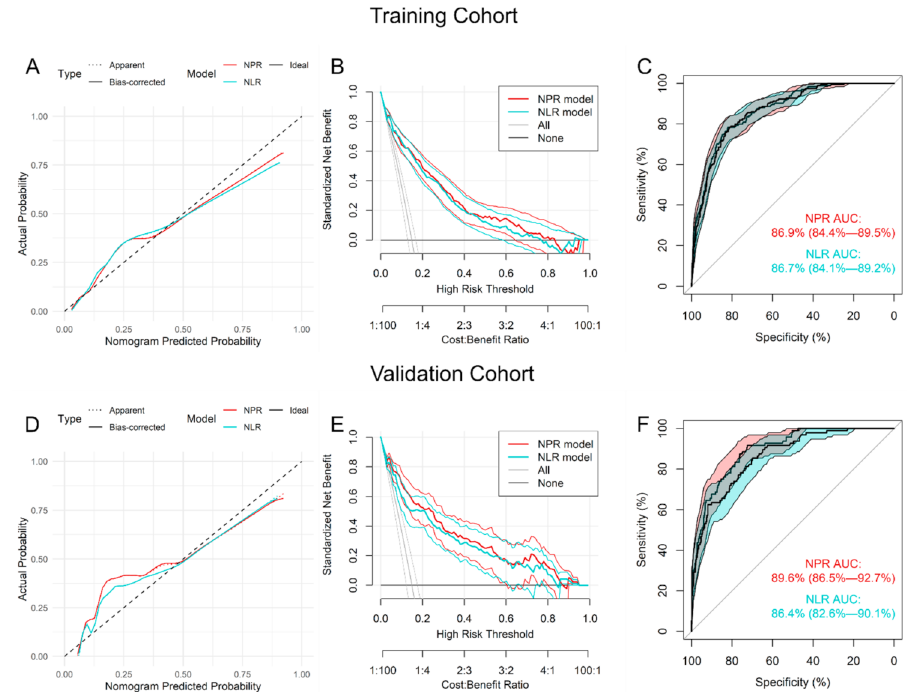
Figure 4. Evaluation of the prediction value of nomograms VNPR (red) and VNLR (blue) in the training ( A–C ) and validation ( D–F ) cohorts. ( A , D ) Calibration plots (pointed lines represent the apparent calibration curves, solid lines represent the bias-corrected calibration curves obtained from the 1000 bootstrap and dashed line represent the ideal calibration curve), ( B , E ) decision curves and ( C , F ) ROC curves of the nomogram score. Abbreviations: NLR, neutrophil-lymphocyte ratio; NPR, neutrophil-platelets ratio; VNLR, velocity neutrophil-lymphocyte ratio; VNPR; velocity neutrophil- platelets